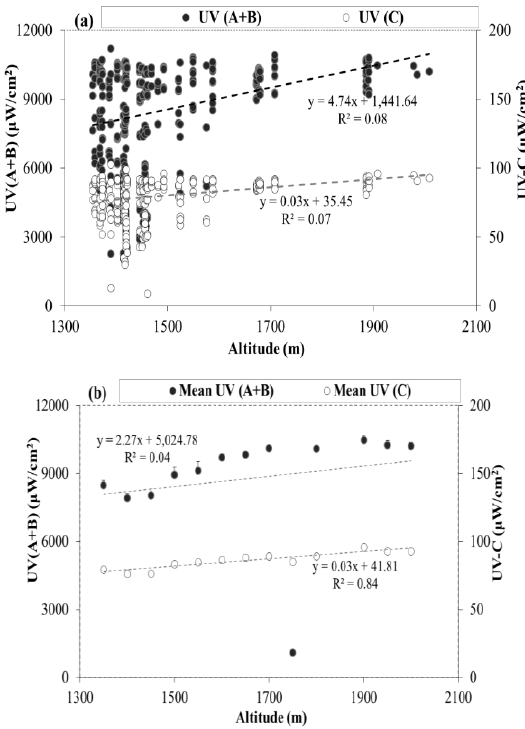
Figure 4 . Scatter plot of UV (A+B) and UV (C) solar irradiances vs. altitude (a), and trend line of mean values of UV (A+B) and UV (C) solar irradiances vs. altitude (b).